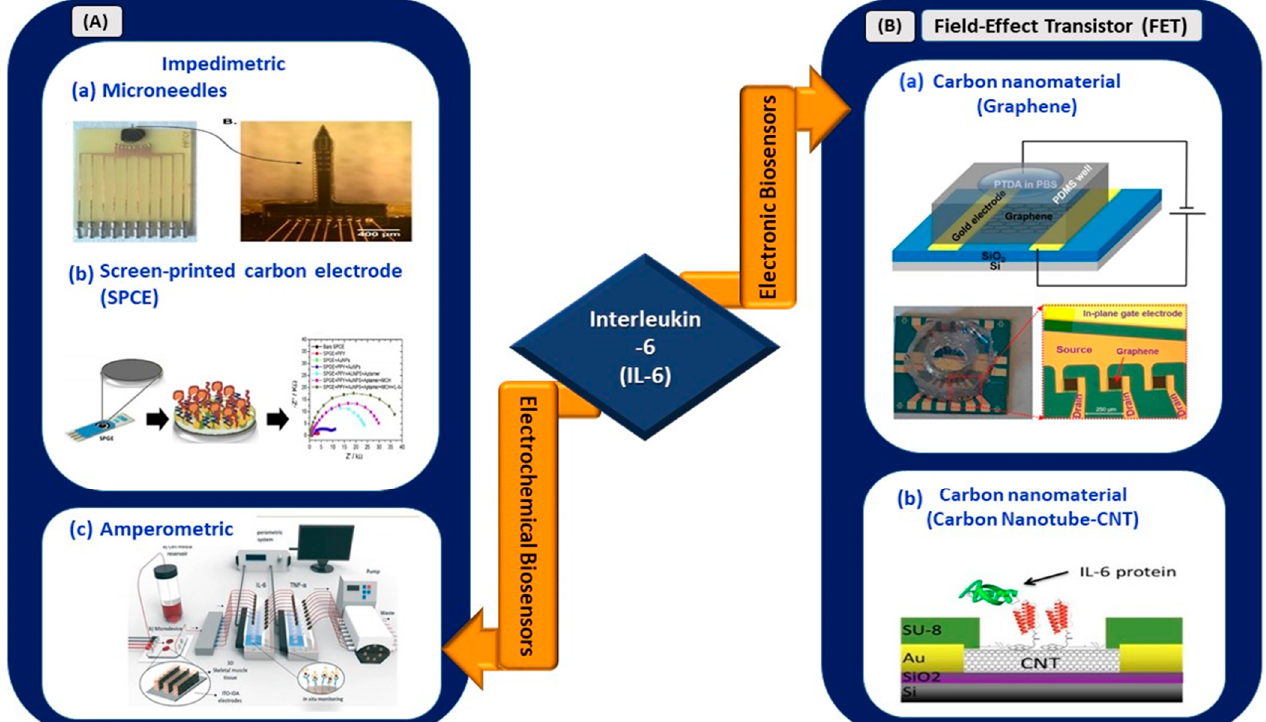
Figure 3. ( A ) Electrochemical biosensors: ( a ) impedimetric detection of IL-6 using microelectrodes with needles structure (reprinted from [40]), ( b ) paper-based impedimetric detection of IL-6 (reprinted with permission from [41]), and ( c ) amperometric sensing system for IL-6 and TNF- α detection (reprinted with permission from [42]). ( B ) Electronic biosensors: ( a ) graphene-based FET biosensor (reprinted from [43]) and ( b ) CNT-based FET biosensor (reprinted from